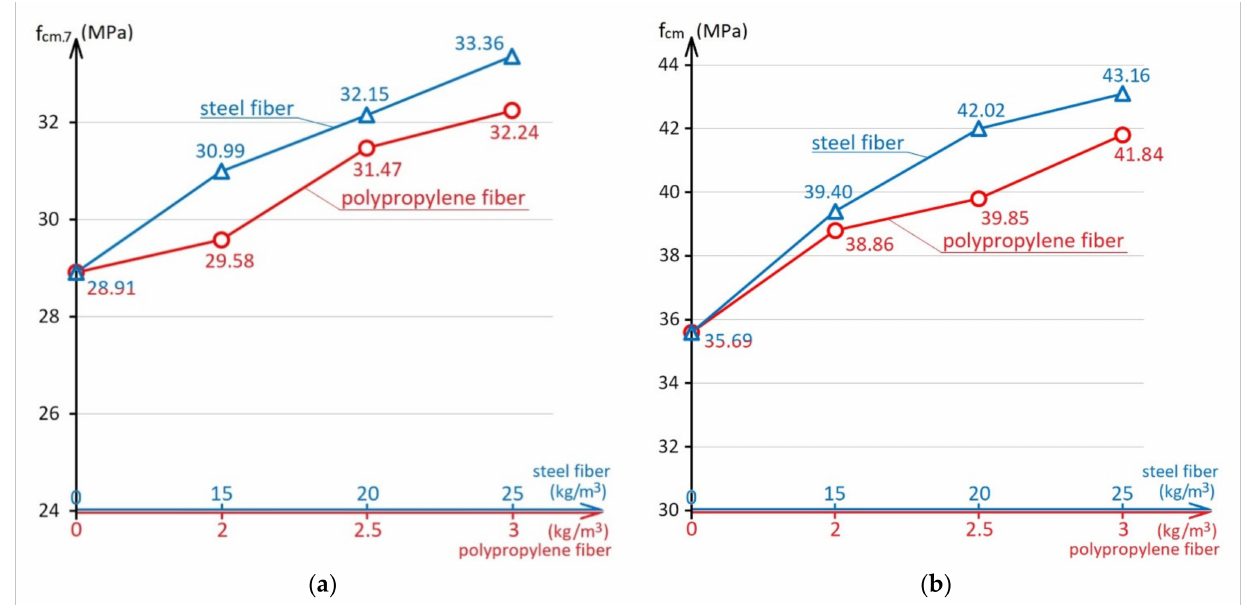
Figure 3. The influence of the steel and polypropylene fibers amount on the concrete compressive strength at 7 days ( a ) and compressive strength at 28 days ( b ).